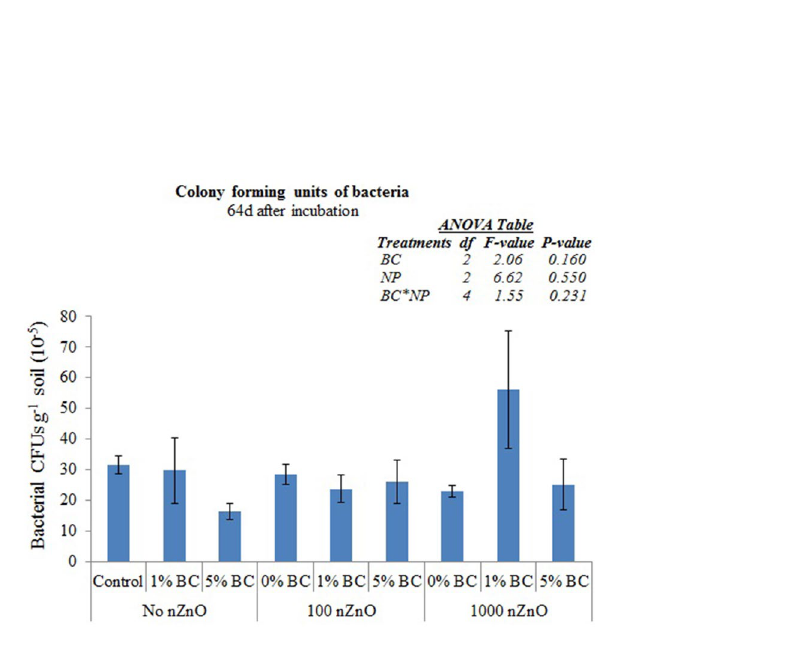
Figure 6. Colony forming units (CFUs) of bacteria found in soils in response to nZnO and BC treatments 64d after incubation. Error bars represent standard errors of means (n =